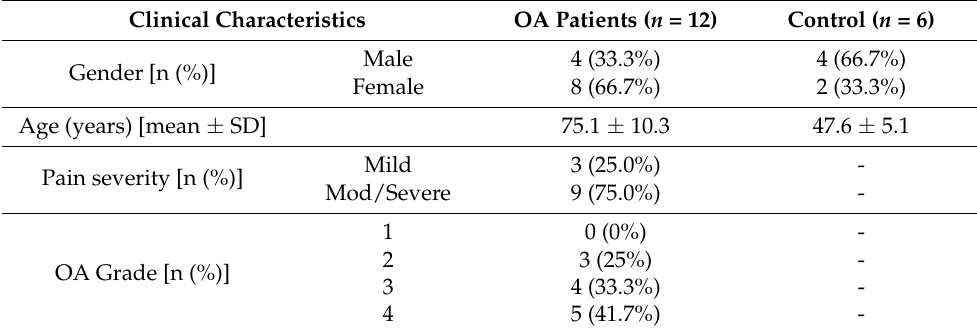
Table 1. Baseline characteristics of patients with osteoarthritis (OA) and control in Shuang-Ho Hospital. Clinical Characteristics OA Patients ( n =